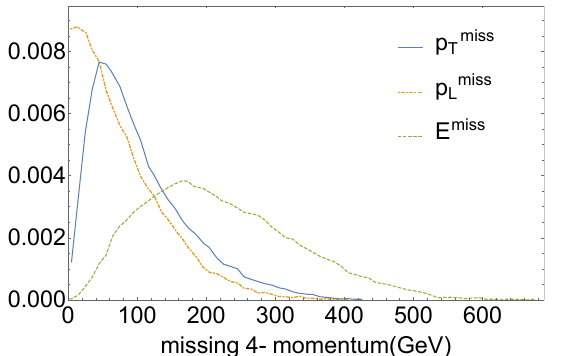
, missing longitudinal T